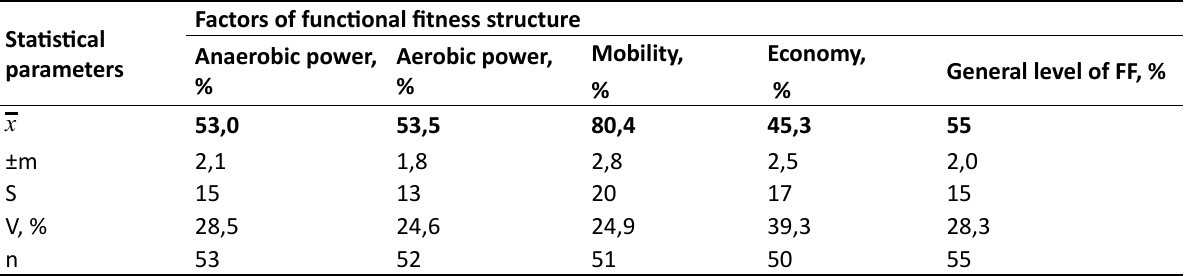
Таble 1. Factors of functional fitness structure of combat athletes according to manifestations of respiratory